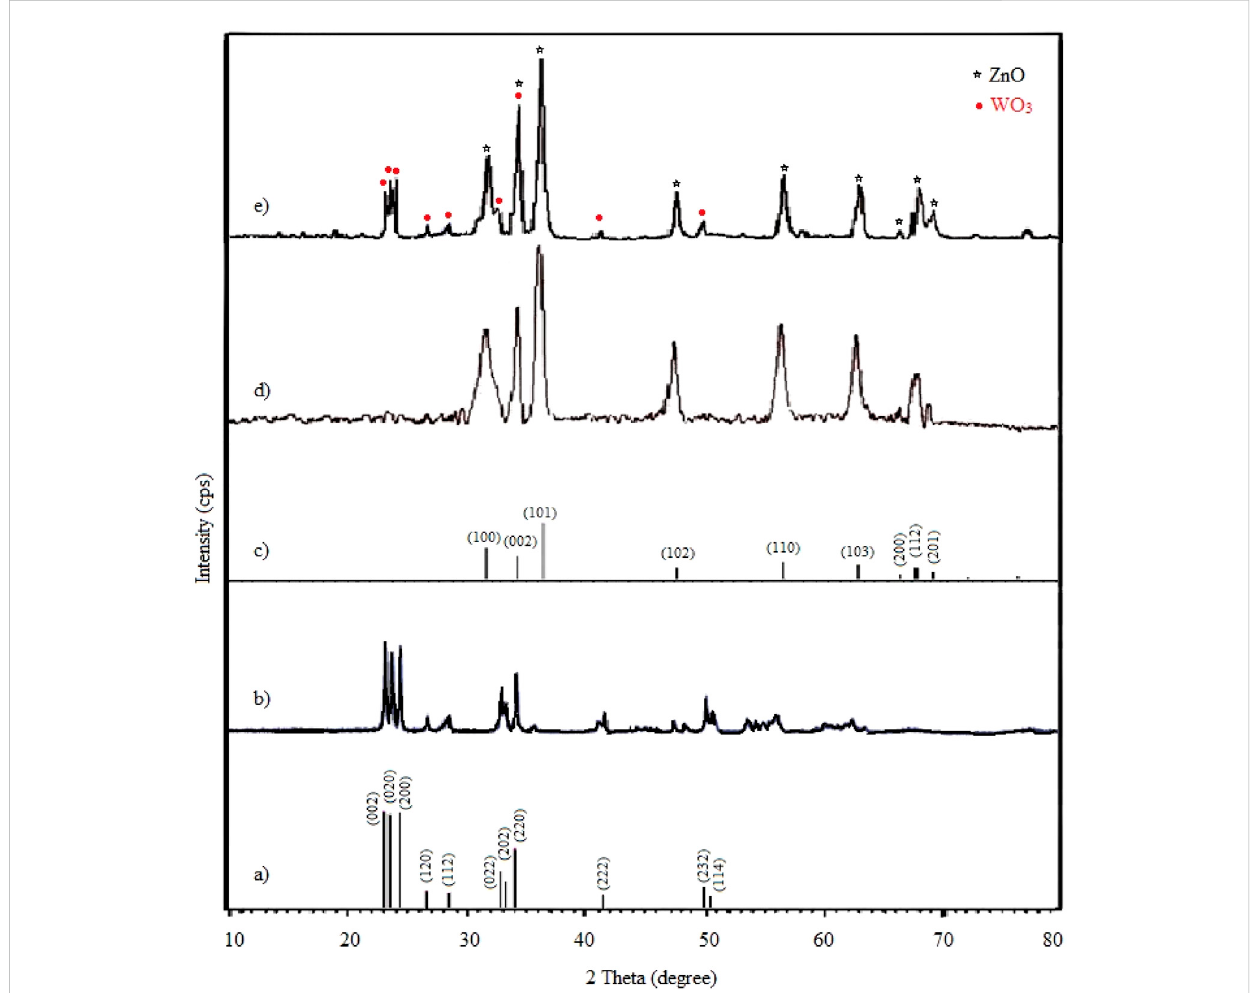
FIGURE 2 Wide-angle XRD pattern of (A) simulated standard WO 3 , (B) synthesized WO 3 , (C) simulated standard ZnO, (D) synthesized ZnO and (E) synthesized